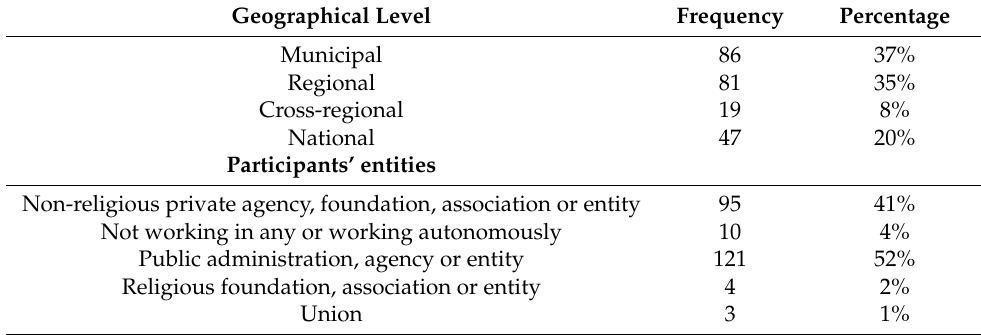
Table A1. Our sample population, by geographical scope, type of organization and subsector.